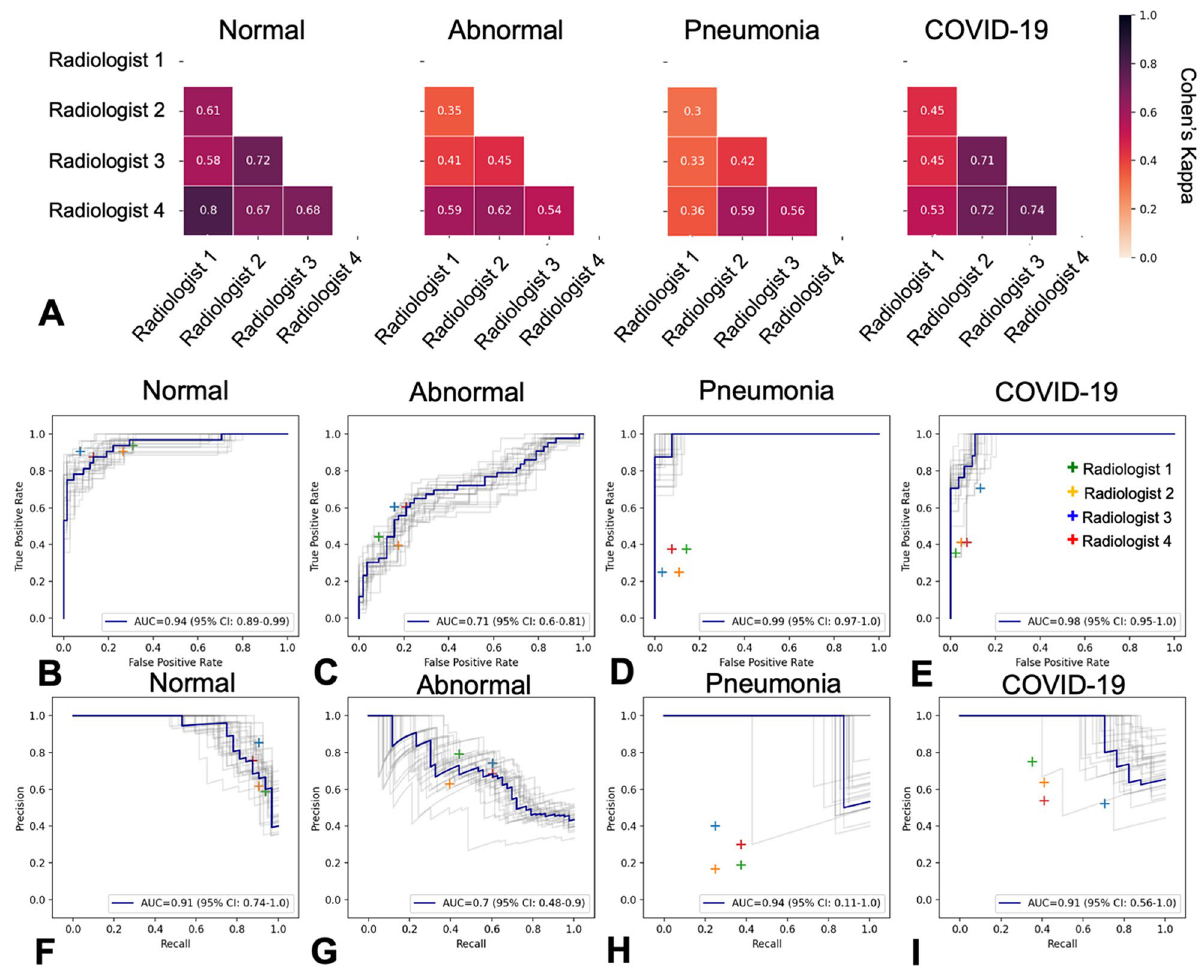
Figure 6. Comparison with board-certified radiologist interpretations. ( A ) Heatmaps visualising inter-reader agreement for Normal, Abnormal, Pneumonia, and COVID-19 images. ( B-E ) Receiver Operating Characteristic (ROC) curves and ( F-I ) Precision-Recall (PR) curves demonstrating CovIx model performance on the first 100 images collected in June 2020 across EDs in NHS GG&C (n = 17 COVID-19 positive). Individual radiologist performance is visualised as “ + ”. Grey lines indicate 95% Confidence Intervals (CI) calculated on 2000 bootstrap